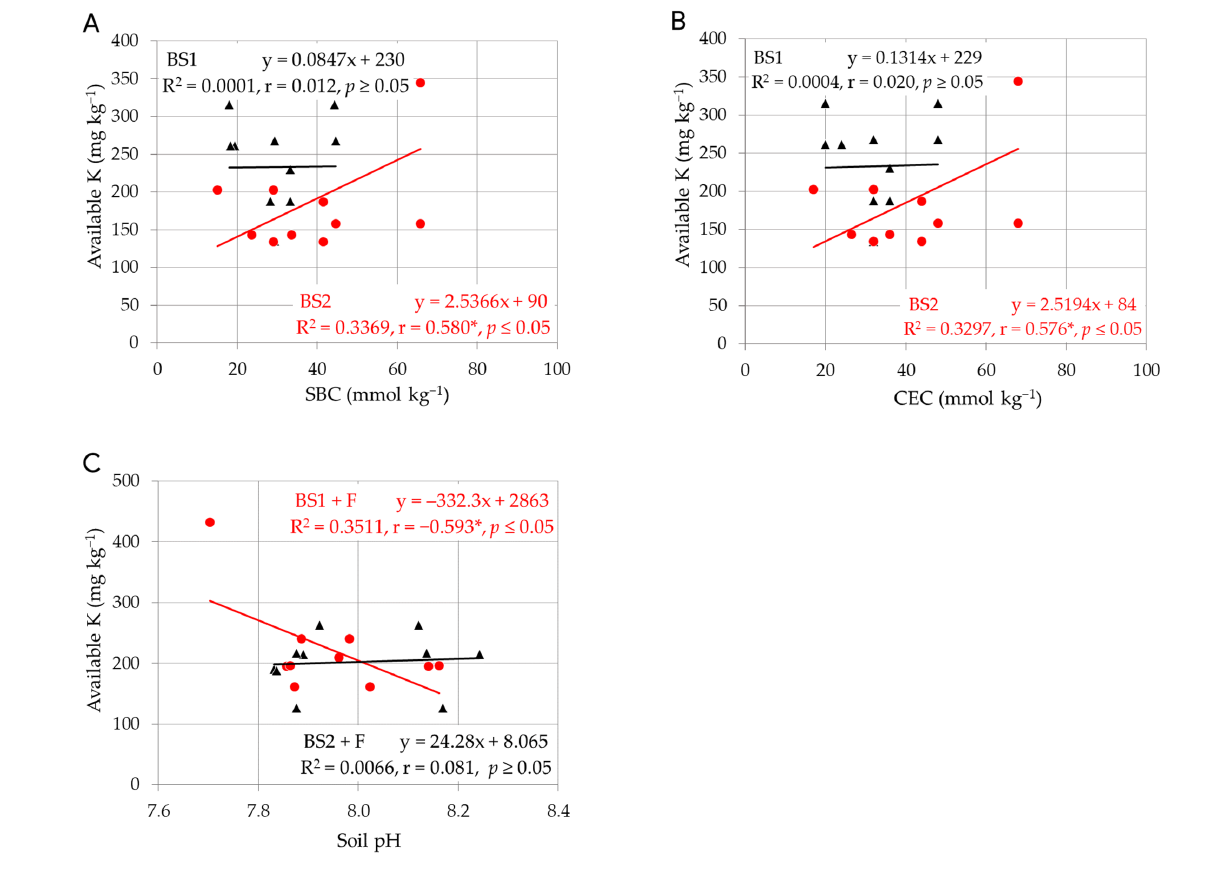
Figure 2. The linear dependence between selected soil properties and K availability for chosen treatments: ( A ) Sum of basic cations (SBC) in nonfertilized treatments in sandy soil; ( B ) Cation exchange capacity (CEC) in nonfertilized treatments in sandy soil; ( C ) Soil pH in fertilized treatments in loamy soil. Red circles and * indicate significant correlation at p ≤